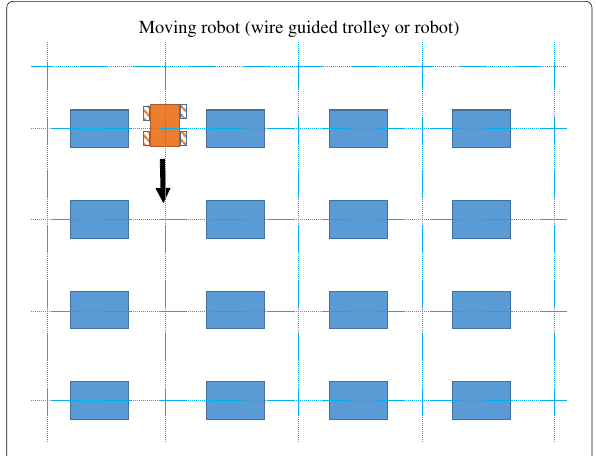
Fig. 1 An application scenario about indoor environment with a set of devices in